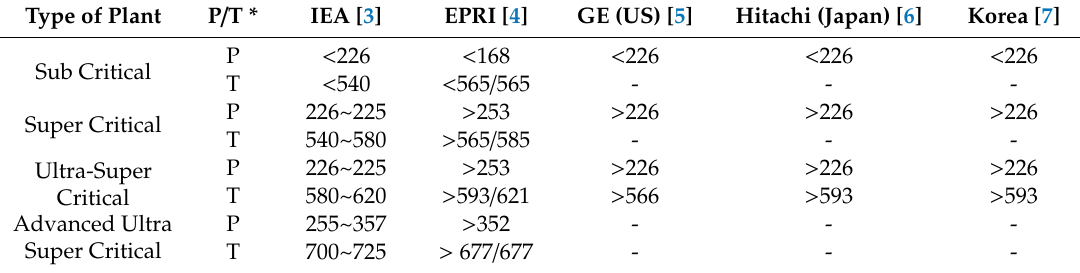
Table 1. The steam condition of 500 MW supercritical pressure coal-fired power